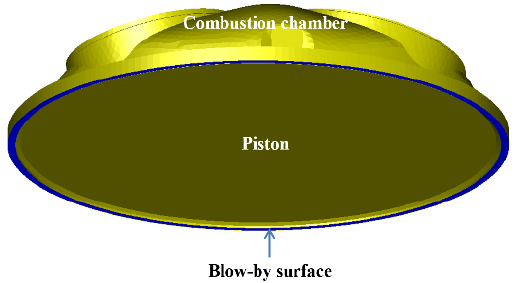
Figure 6. Imposing the blow-by flow rate as a boundary condition.